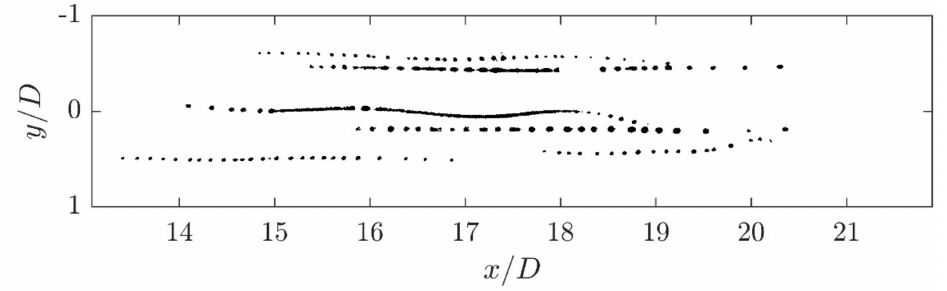
Figure 22. Visualization of several droplet break-up processes following the Plateau-Rayleigh instability mechanism during eccentric droplet injection (r ∗ = 0.75) and at Re =